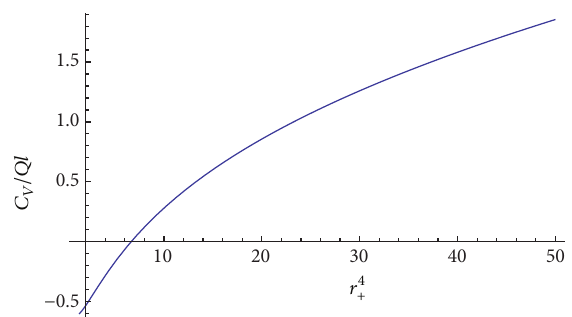
Figure 1: Plots of the heat capacity at constant 𝑉 and 𝑄 versus the 𝑟 4 + . The horizontal axis started from 4/3, because of intersection point of 𝐶 𝑉,𝑄 with the horizontal axis is 20/3, which shows that when 𝑟 4 + > (20/3)𝑄 2 𝑙 4 holds up, 𝐶 𝑉,𝑄 > 0